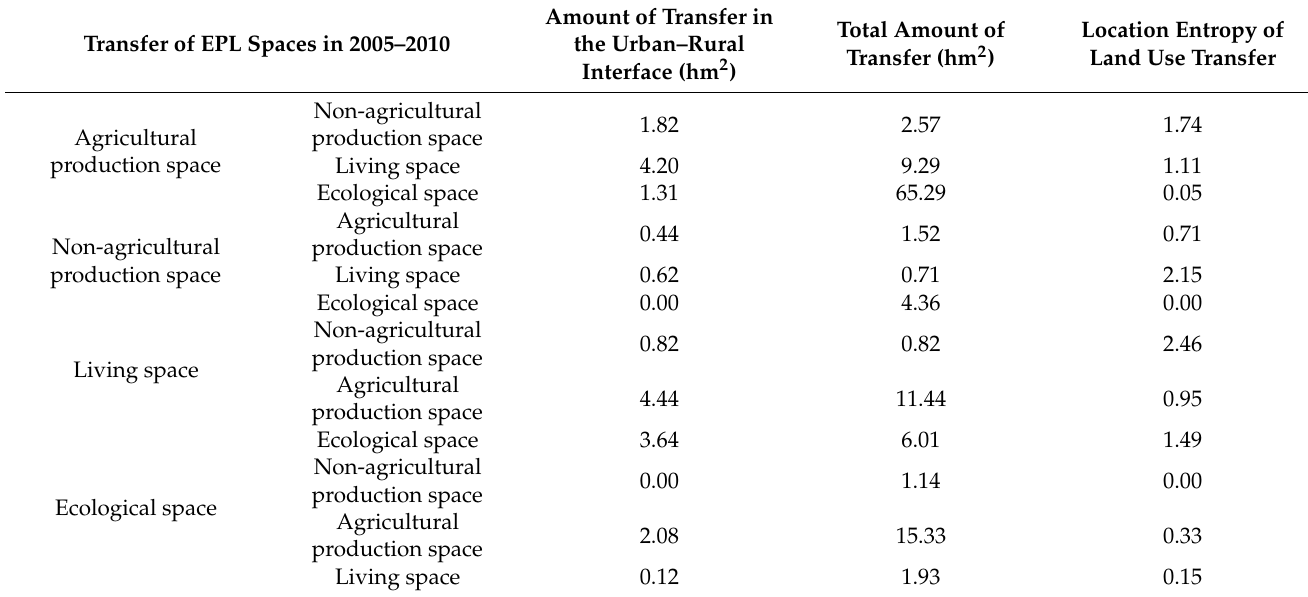
Table 10. Spatial transfer of EPL spaces in the urban–rural interface area from 2005 to 2010.